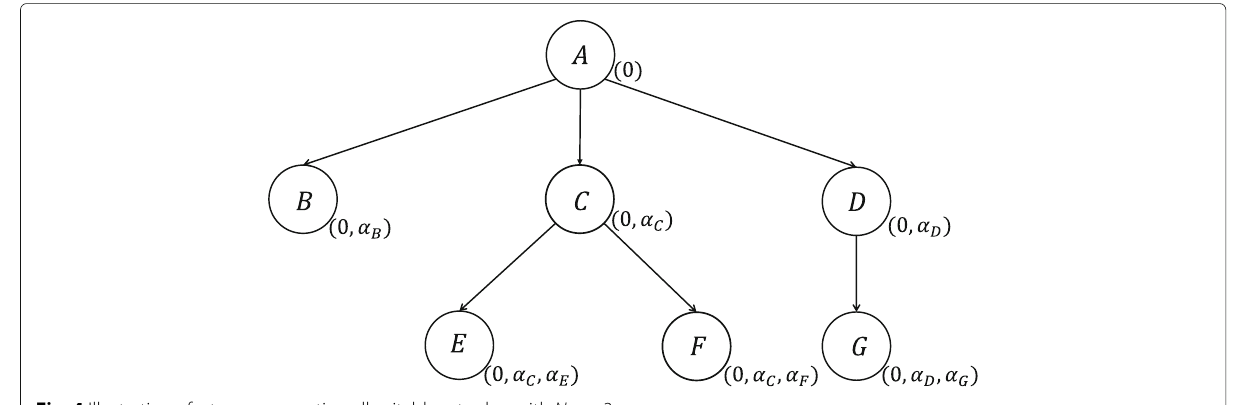
Fig. 4 Illustration of a tree representing all suitable n -tuples, with N C = 3